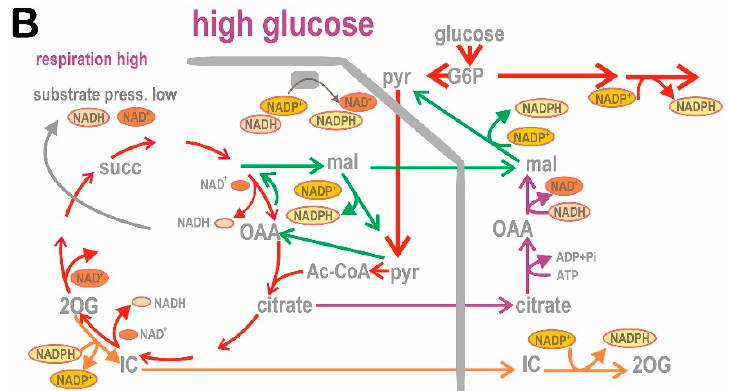
Figure 6. Redox shuttles—( A ) operate at minimum in low glucose conditions, but ( B ) at maximum in the high glucose conditions. The key enzyme for the pyruvate/malate shuttle (green arrows) is the pyruvate carboxylase (PC) allowing the reverse malate dehydrogenase (MDH) reaction and following the export of malate (Mal) to the cytosol, where malic enzyme 1 (ME1) forms NADPH. As a result, instead of NADH, which would otherwise be made by MDH, a cytosolic NAPDH is formed. Similar consequences result from the operation of the pyruvate/citrate shuttle and pyruvate/isocitrate shuttle (“IC”, isocitrate). The latter involves NADPH-dependent reductive carboxylation by isocitrate dehydrogenase 2 (IDH2) in the mitochondrial matrix, followed by the export of the formed IC, and oxidative decarboxylation by the cytosolic IDH1, forming NADPH, which again contributes to the elevated cytosolic NADPH pool. Note that the operation of these shuttles under conditions of high glucose excludes the operation of the malate/aspartate, which requires exactly the opposite 2-oxoglutarate